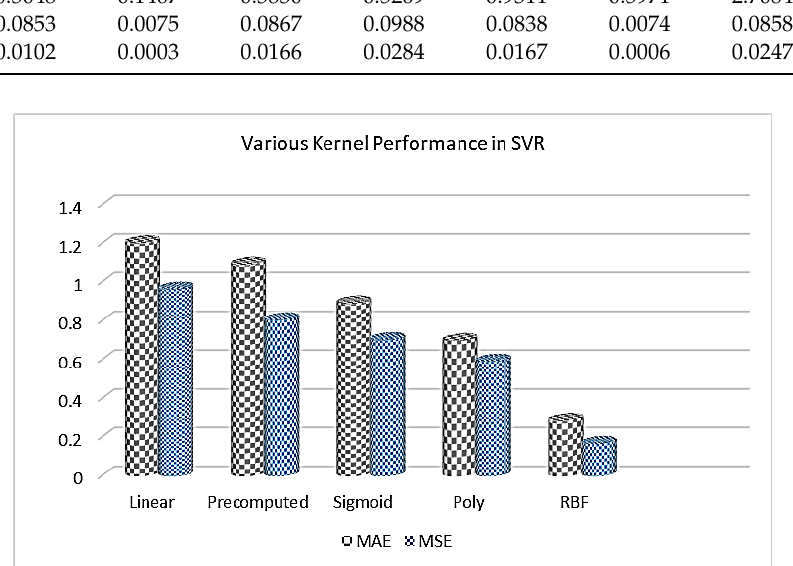
Figure 7. Numerous kernel performances of SVR in the prediction of HL and CL. Table 4. Experimental results of various ML and DL models for SO prediction using the hold-out method.